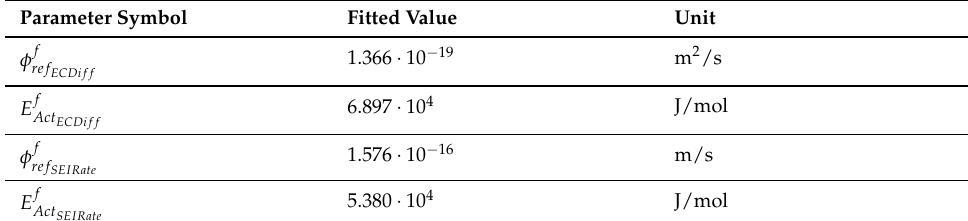
Table 11. Fitted parameter values on calendar aging test at temperature 25 ◦